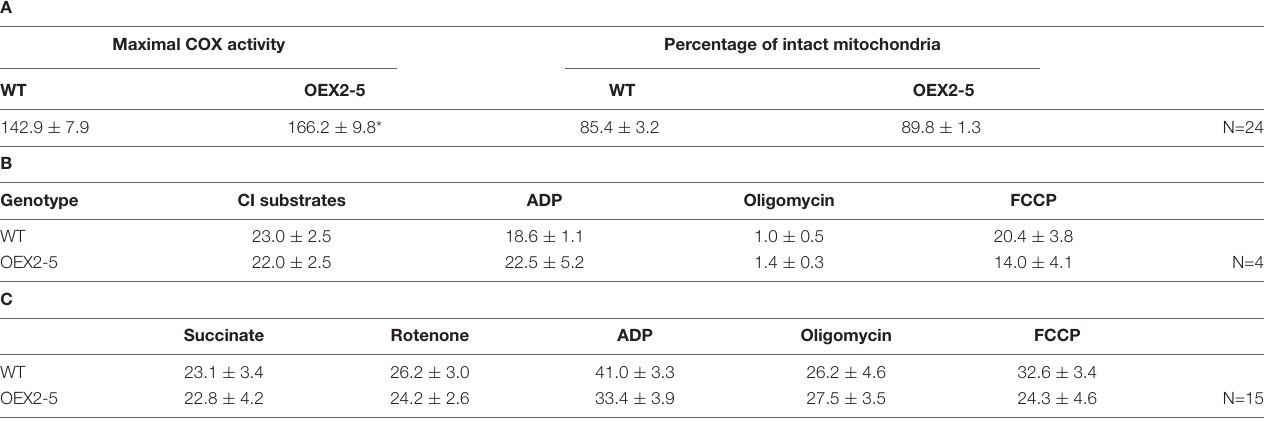
A Maximal COX activity Percentage of intact